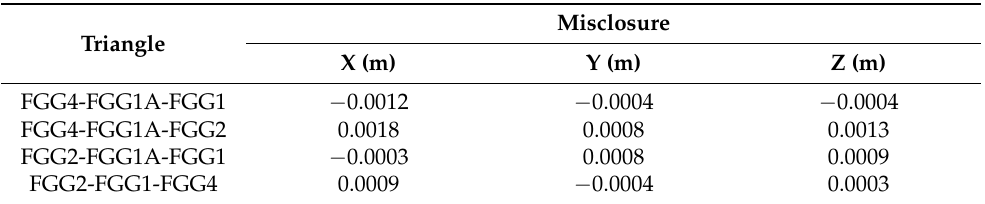
Table 10. Misclosures of triangles for the geodetic GNSS instruments.